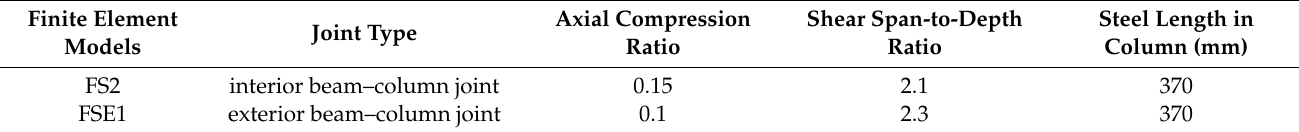
Table 3. General information of the finite element models.